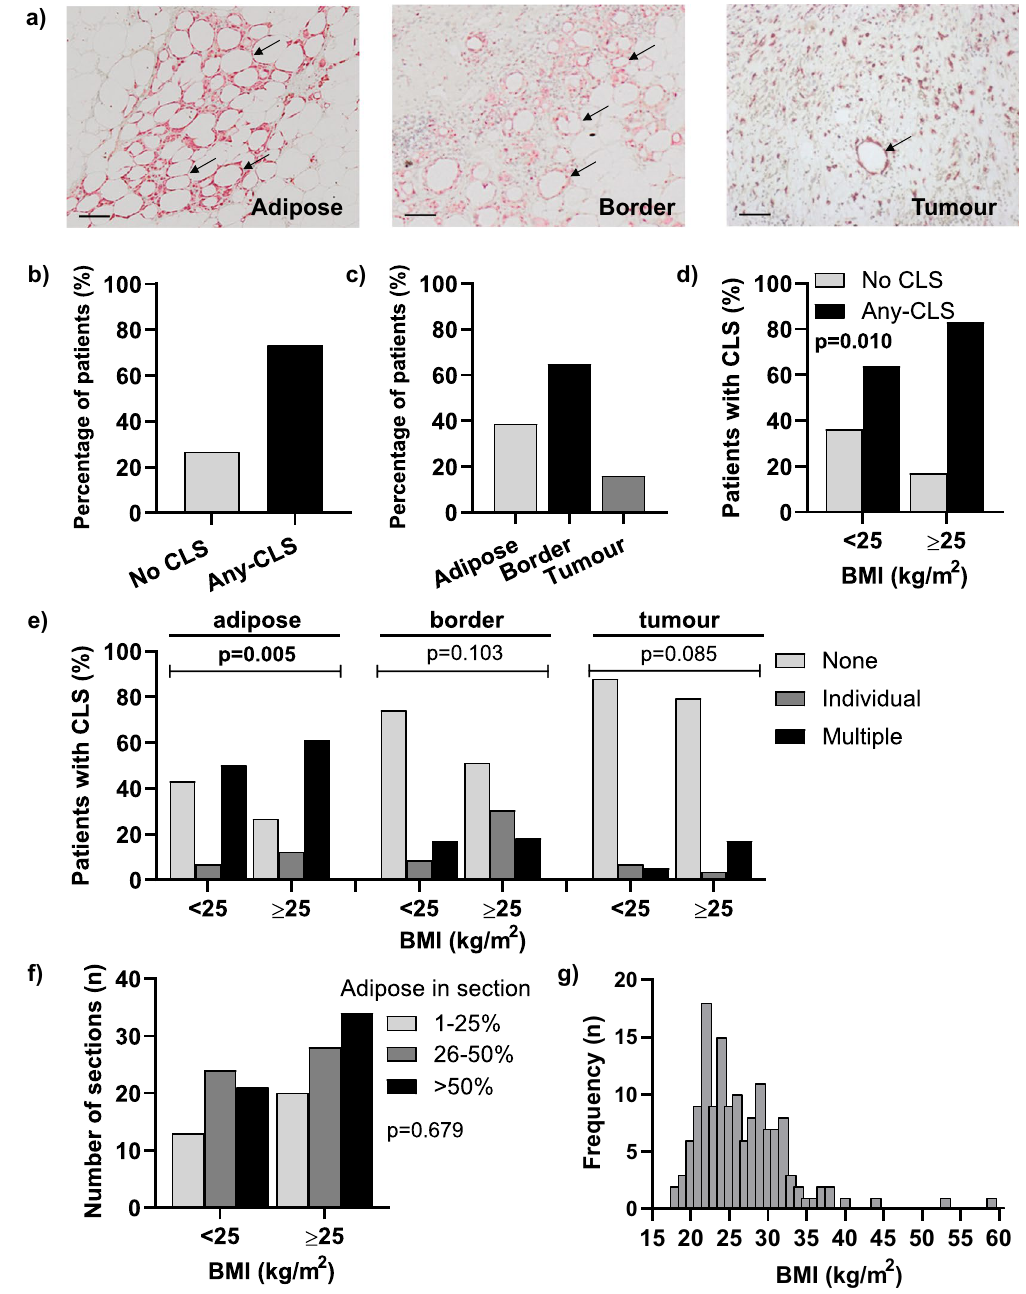
Figure 1. Frequency and spatial distribution of CLS. ( a ) Representative images showing the spatial distribution of CLS either in the adipose, at the adipose-tumour border, or within the tumour. Arrows indicate examples of CLS at each location. Scale bar = 100 μm; Refine red, CD68; ( b ) Percentage of patient tissue sections in cohort that contained at least 1 CLS in any location; ( c ) Spatial distribution of CLS in patients with at least 1 CLS; ( d ) Presence of at least 1 CLS in any location stratified by BMI; ( e ) CLS quantification stratified by frequency, spatial distribution, and BMI; ( f ) Proportion of adipose tissue in each tissue section stratified by BMI; ( g ) Distribution of patient BMI across the whole cohort is representative of the general population. P values were calculated with Pearson’s Chi-square or Fisher exact test if one or more of cells had an expected frequency of 5 or